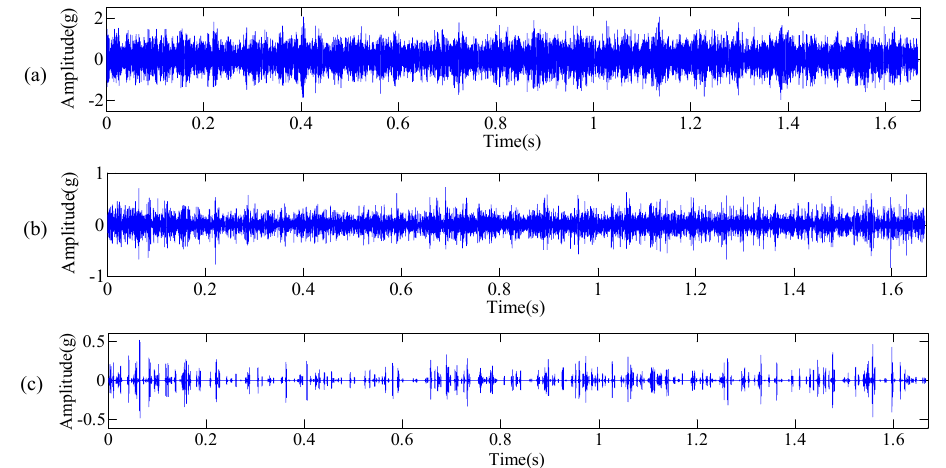
Figure 6. In 60 h: ( a ) Raw vibration signals; ( b ) reconstructed component via Dual − BP; ( c ) reconstructed component via MCA.